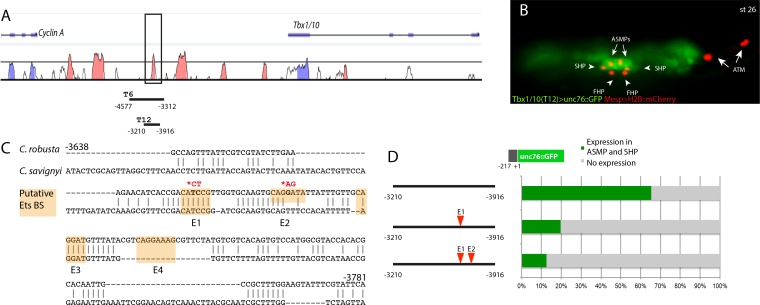
The Tbx1/10 enhancer has conserved putative Ets binding sites required for reporter gene expression.(A) Alignment of Tbx1/10 locus between Ciona robusta/Ciona savignyi using VISTA. (B) Ciona larva (st 26) expressing GFP driven by the T12 element, a STVC-specific Tbx1/10 enhancer (green) and Mesp > H2B::mCherry to track the B7.5 lineage cell nuclei (red). The Tbx1/10 enhancer drives the unc76::GFP reporter in the STVC progeny, including ASM precursors (ASMPs) (white arrows) and the second heart precursors (SHPs) (white arrowheads). No expression is detected in the first heart precursors (FHPs) (white arrowheads) and anterior tail muscle (ATMs) (orange arrows). (C) Sequence alignment of Tbx1/10 enhancer between Ciona robusta/Ciona savignyi Conserved blocks in the orange boxes with putative Ets binding sites. (D) Proportion of larvae expressing both GFP and mCherry in the STVC progeny when co-electroporated wild-type and mutant Tbx1/10 reporters lacking the indicated putative Ets binding sites and Mesp > H2B::mCherry in comparison to the control (no enhancer, only Tbx1/10 basal promoter driving unc::76GFP). n: number of electroporated larval halves.